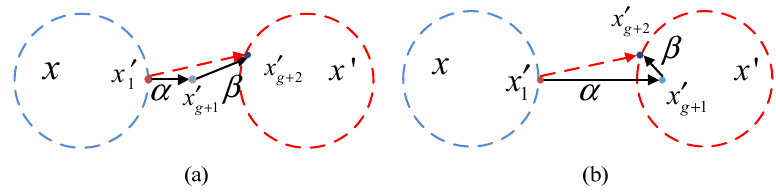
Figure 3. Self-adaptive two-step perturbation.